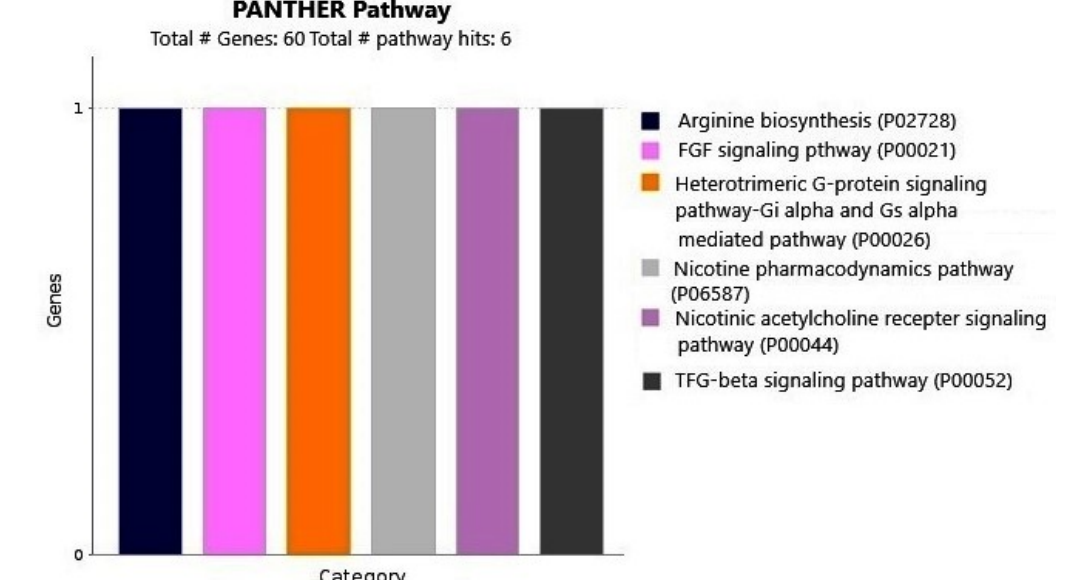
Figure 2. Panther database analysis showing pathway analysis of genes present on 36 BAC clones.